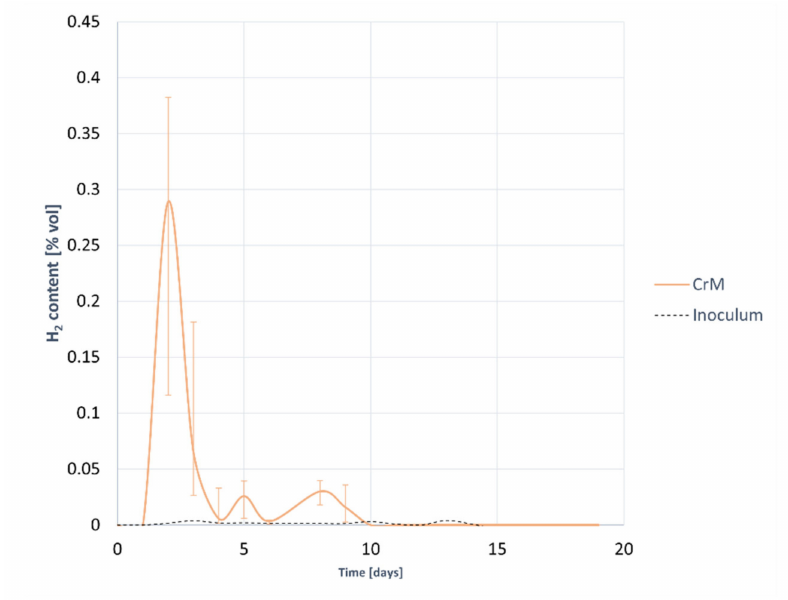
Figure 5. Hydrogen content mean curve from the biogas produced in the anaerobic digestion of 100 g of residue